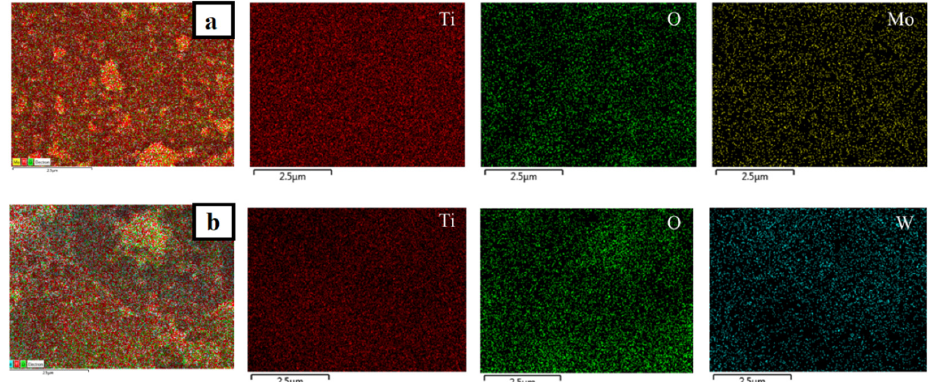
Figure 10. EDS mapping images of ( a ) Mo ‐ TiO 2 and ( b ) W ‐ TiO 2 .